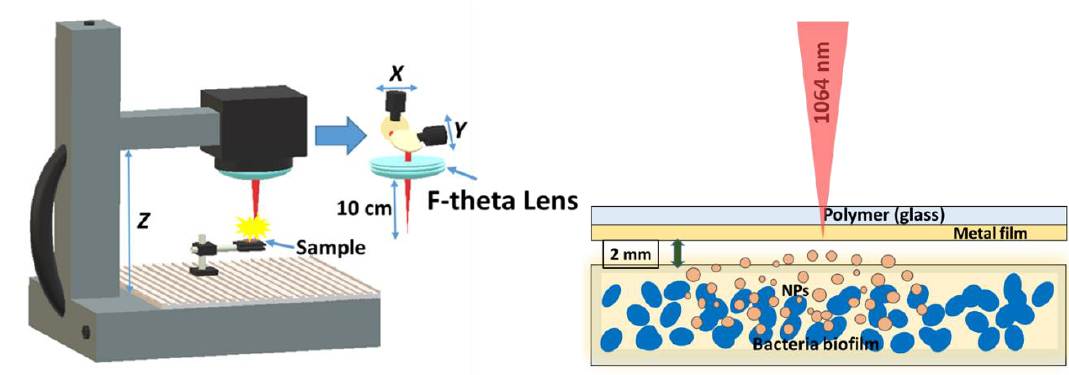
Figure 1. Experimental layout of laser-induced forward transfer of nanoparticles from a transparent substrate (polymer PET or silica glass) onto biofilms of pathogenic microorganisms